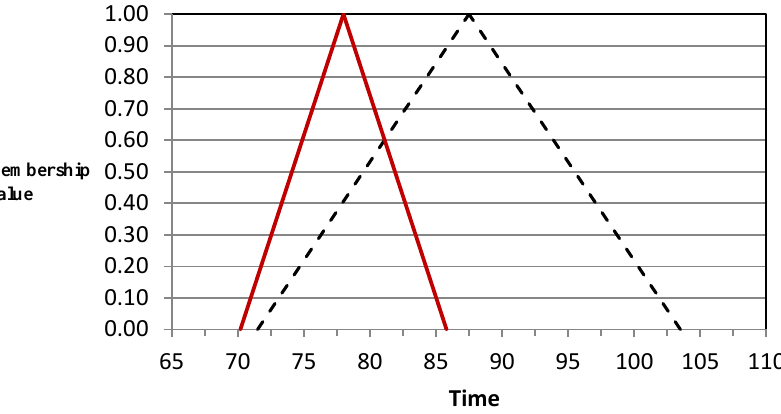
Figure 3. A Particular scheduled time TFN [70.2, 78, 85.8] in